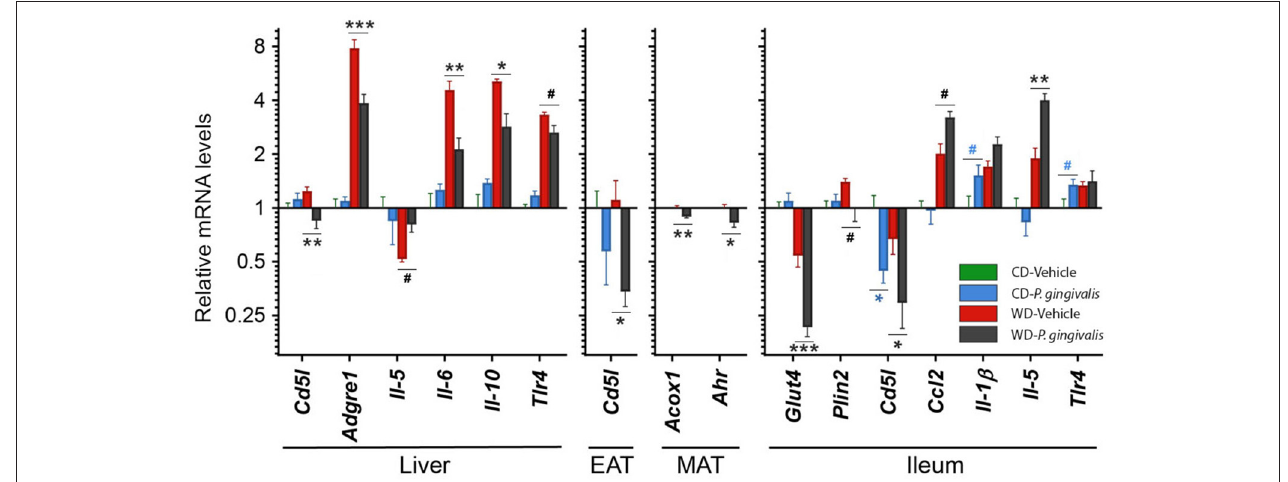
FIGURE 3 | P. gingivalis infection promotes intestinal and hepatic inflammation in mice fed a Western diet. Expression profiles obtained from the liver, mesenteric adipose tissue or MAT, epididymal adipose tissue or EAT, and ileum. Gene expression, from mice fed a CD or a WD and either infected with P. gingivalis or treated with vehicle, was normalized relative to the baseline group (vehicle-treated mice fed a CD) and reported on a log 2 scale as mean ± SEM. CD, control diet; WD, Western diet. Green = vehicle-treated mice fed a CD, blue = P. gingivalis -infected mice fed a CD; red = vehicle-treated mice fed a WD, black = P. gingivalis -infected mice fed a WD. Significance measured by a one-way ANOVA with a post-hoc Tukey test. Asterisks represent significant difference between P. gingivalis - vs. vehicle-treated mice fed a CD (blue asterisks) or fed a WD (gray asterisks). (# p < 0.1), * p < 0.05, ** p < 0.01, *** p < 0.001. Genes with p > 0.1 are reported in Supplementary Material . n = 5–8/group.